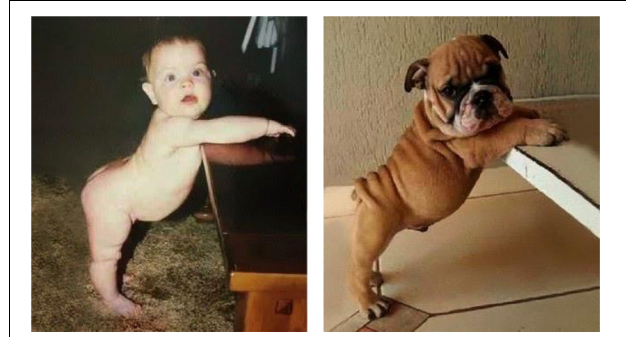
FIGURE 2 | Metaphor: baby and